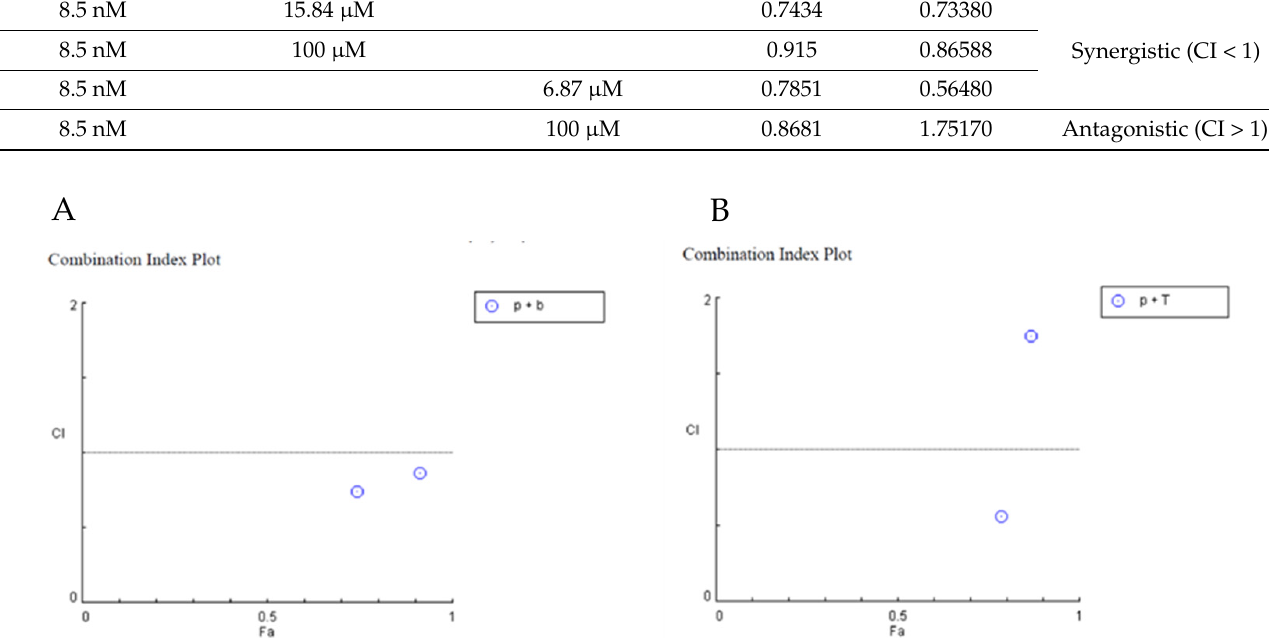
Table 2. CI values and respective effect of the combination of paclitaxel with benztropine and thioridazine . Dose of Paclitaxel